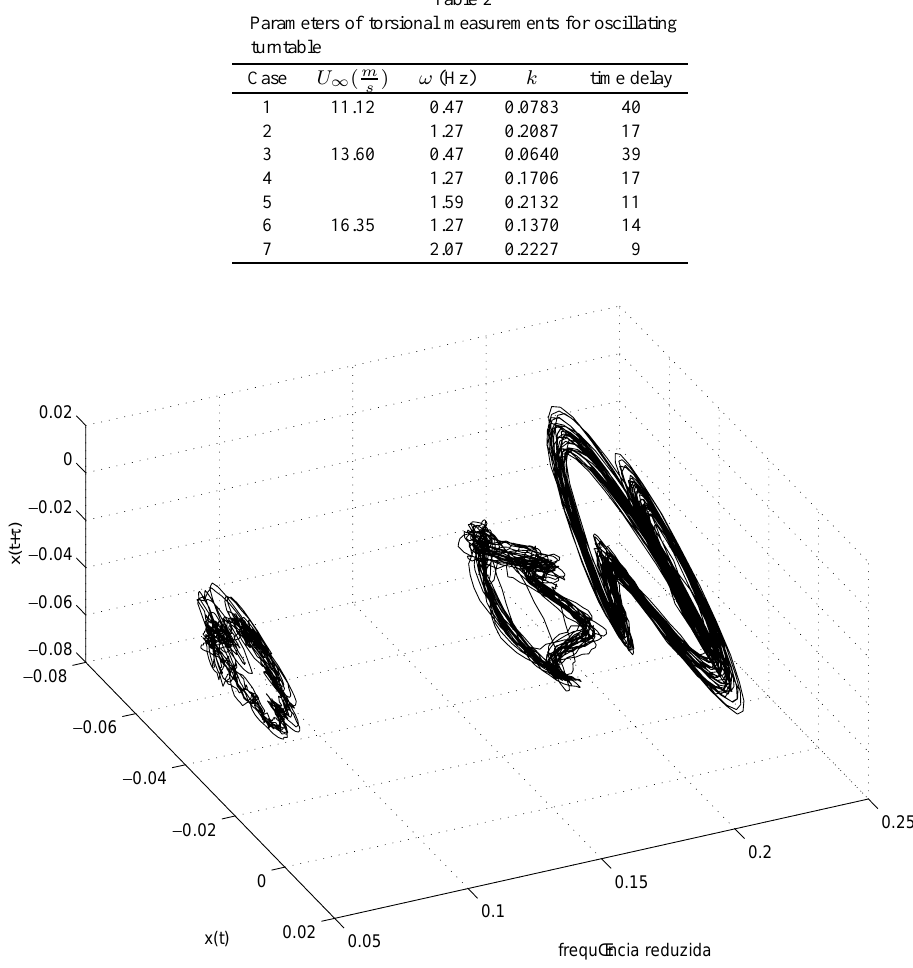
Fig. 6. Reconstructed state spaces for bending measurements with reduced frequency variation (cases 3 to 5 from Table